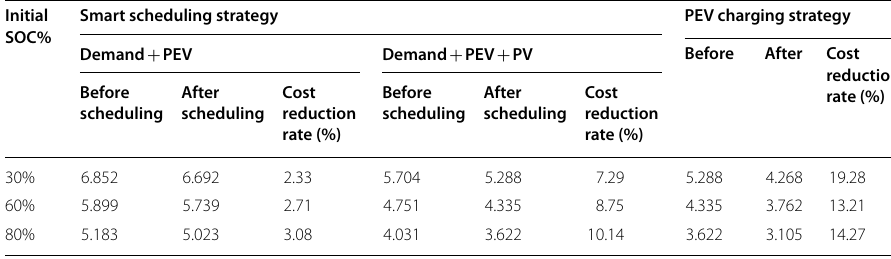
Table 5 Total cost and cost reduction of all simulation cases Initial